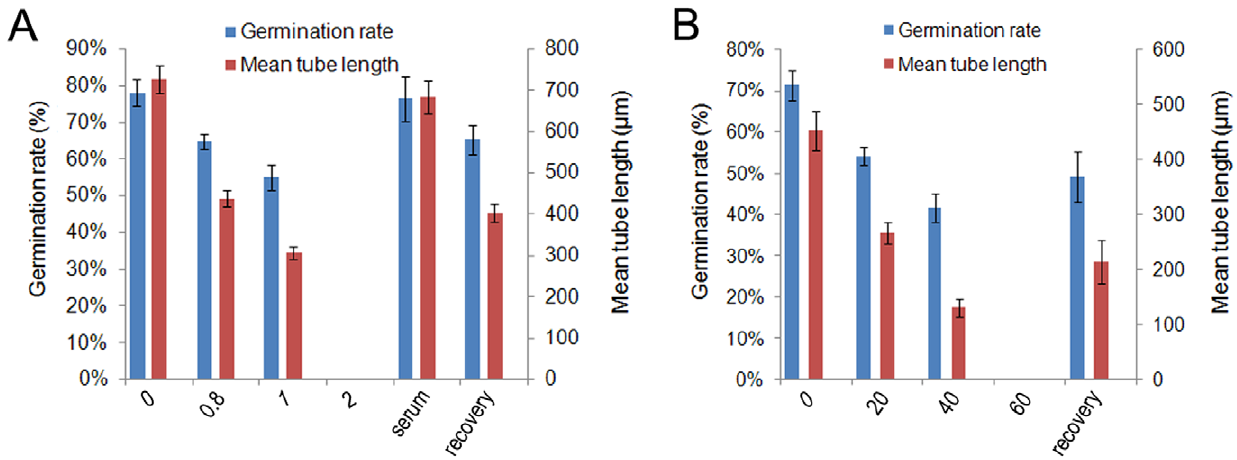
Figure 1. Inhibitory effects of anti-CaM and W7-agarose on pollen germination and pollen tube growth. A, Inhibitory effect of anti-CaM on pollen germination and tube elongation. Numbers on X-axis indicate concentrations of anti-CaM. Pollen tubes incubated in the presence of 1 m g/ mL anti-CaM were collected to remove the pharmacological agent, then pollen tubes were further incubated in standard medium for recovery tests before statistical analysis. B, Inhibitory effect of W7-agarose on pollen germination and tube elongation. Numbers on X-axis indicate concentrations of W7-agarose. Pollen tubes incubated in the presence of 40 m M W7-agarose were collected to remove the pharmacological agent, then pollen tubes were further incubated in standard medium for recovery tests before statistical